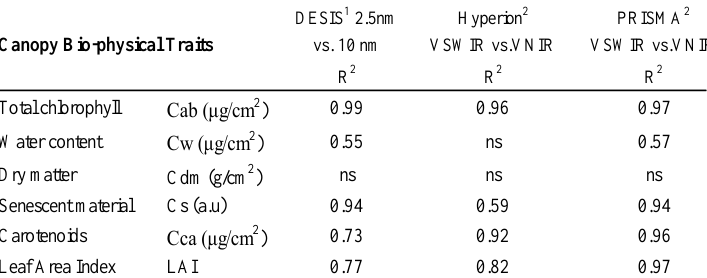
Table 3. Correlation (R 2 ) between canopy traits derived using the original DESIS and Hyperion reflectance, versus DESIS 10 nm resolution and Hyperion VNIR